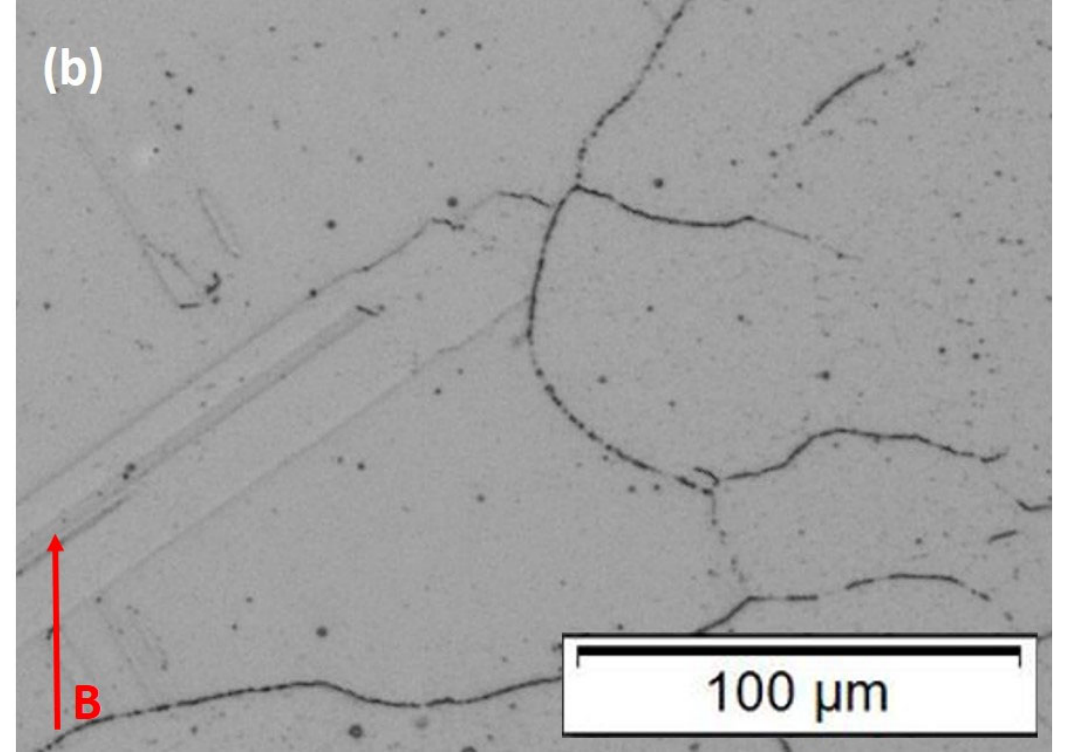
Figure 6. Heat-treated samples. Magnified images. ( a ) 50 µm, layer thickness; ( b ) 100 µm layer thickness. B denotes the build direction.